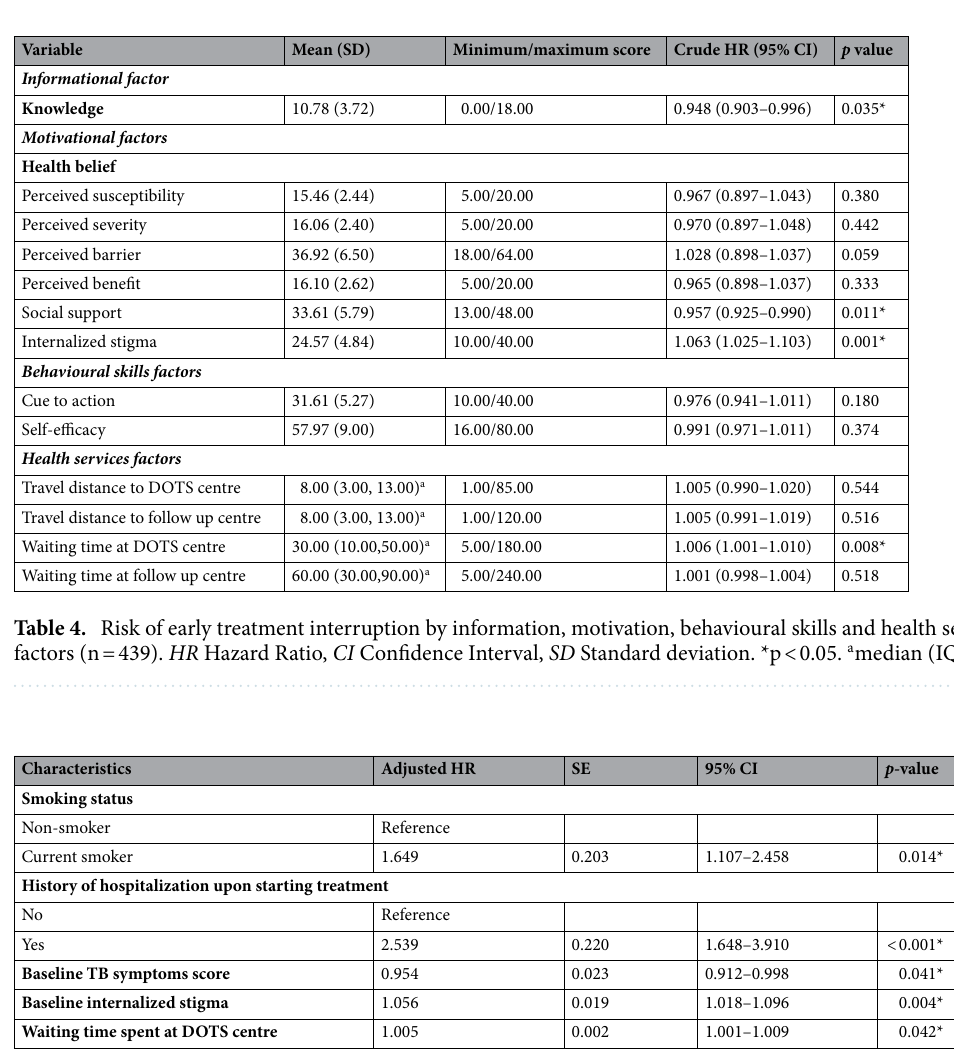
Table 5. Risk factors for early treatment interruption among pulmonary TB smear-positive patients in urban districts, Selangor (n = 439). Using the backward LR method, Cox PH regression – χ 2 = 53.50, df = 5, p < 0.001, PH assumptions were tested using correlation tests between partial residuals and survival time rank (nonsignificant correlations, p > 0.05 were reported), and no issue of multicollinearity was detected. HR Hazard Ratio, SE Standard Error, CI Confidence Interval. *p <